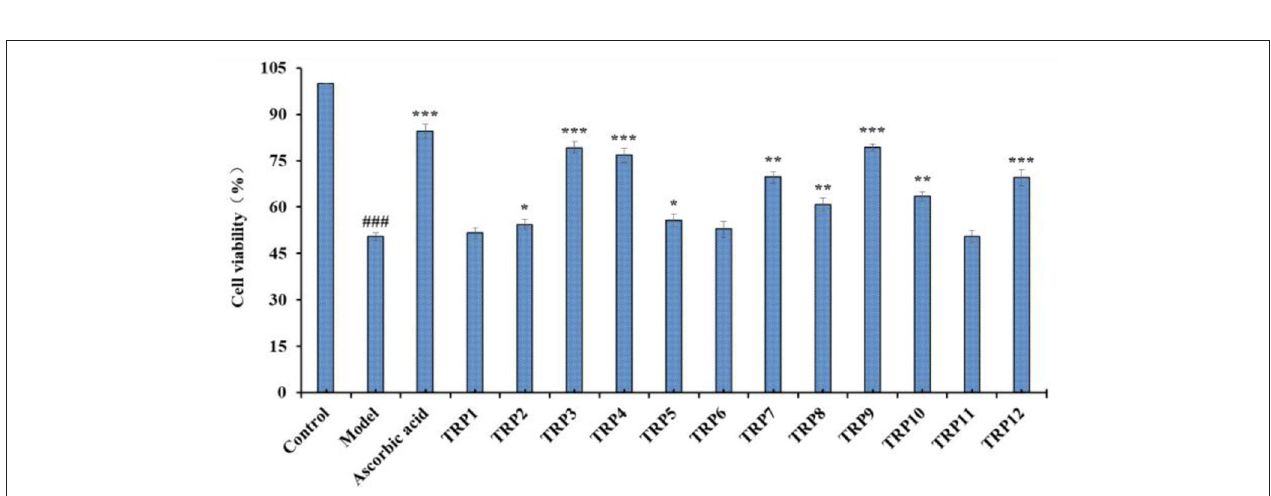
FIGURE 9 | Effects of 12 isolated APs (TRP1 to TRP12) on the cell viability of H 2 O 2 (300 µ mol/L)-induced Chang liver cells. ### p < 0.01 vs. blank control group; * p < 0.05, ** p < 0.01, and *** p < 0.001 vs. model group.